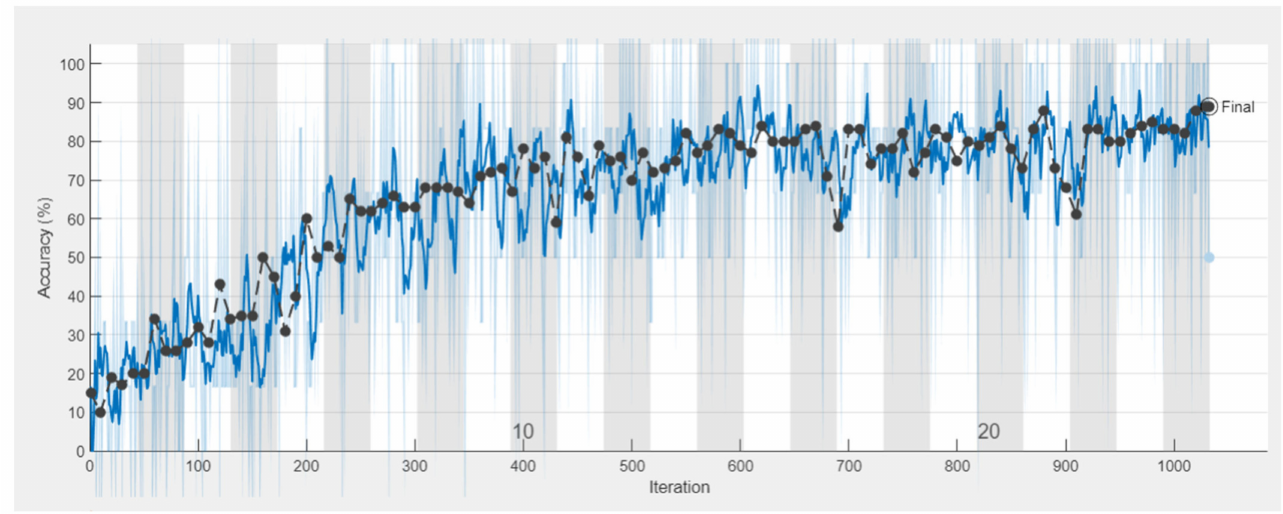
Figure 11. Training and validation accuracy progress for the seven classes of current signal classification: training in light blue and in blue (smoothed), validation in black dashed.